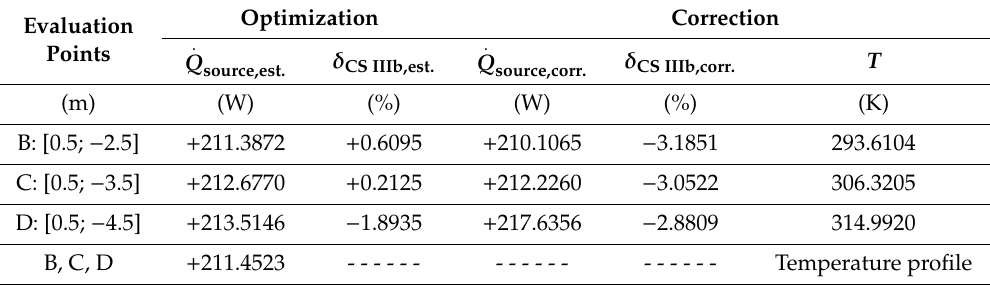
Table 13. Case study IIIb: Estimation of the positive heat source . Q source,corr. to thermodynamic temperatures T B , T C , and T D for evaluation points B, C, and D (for points and a thermal